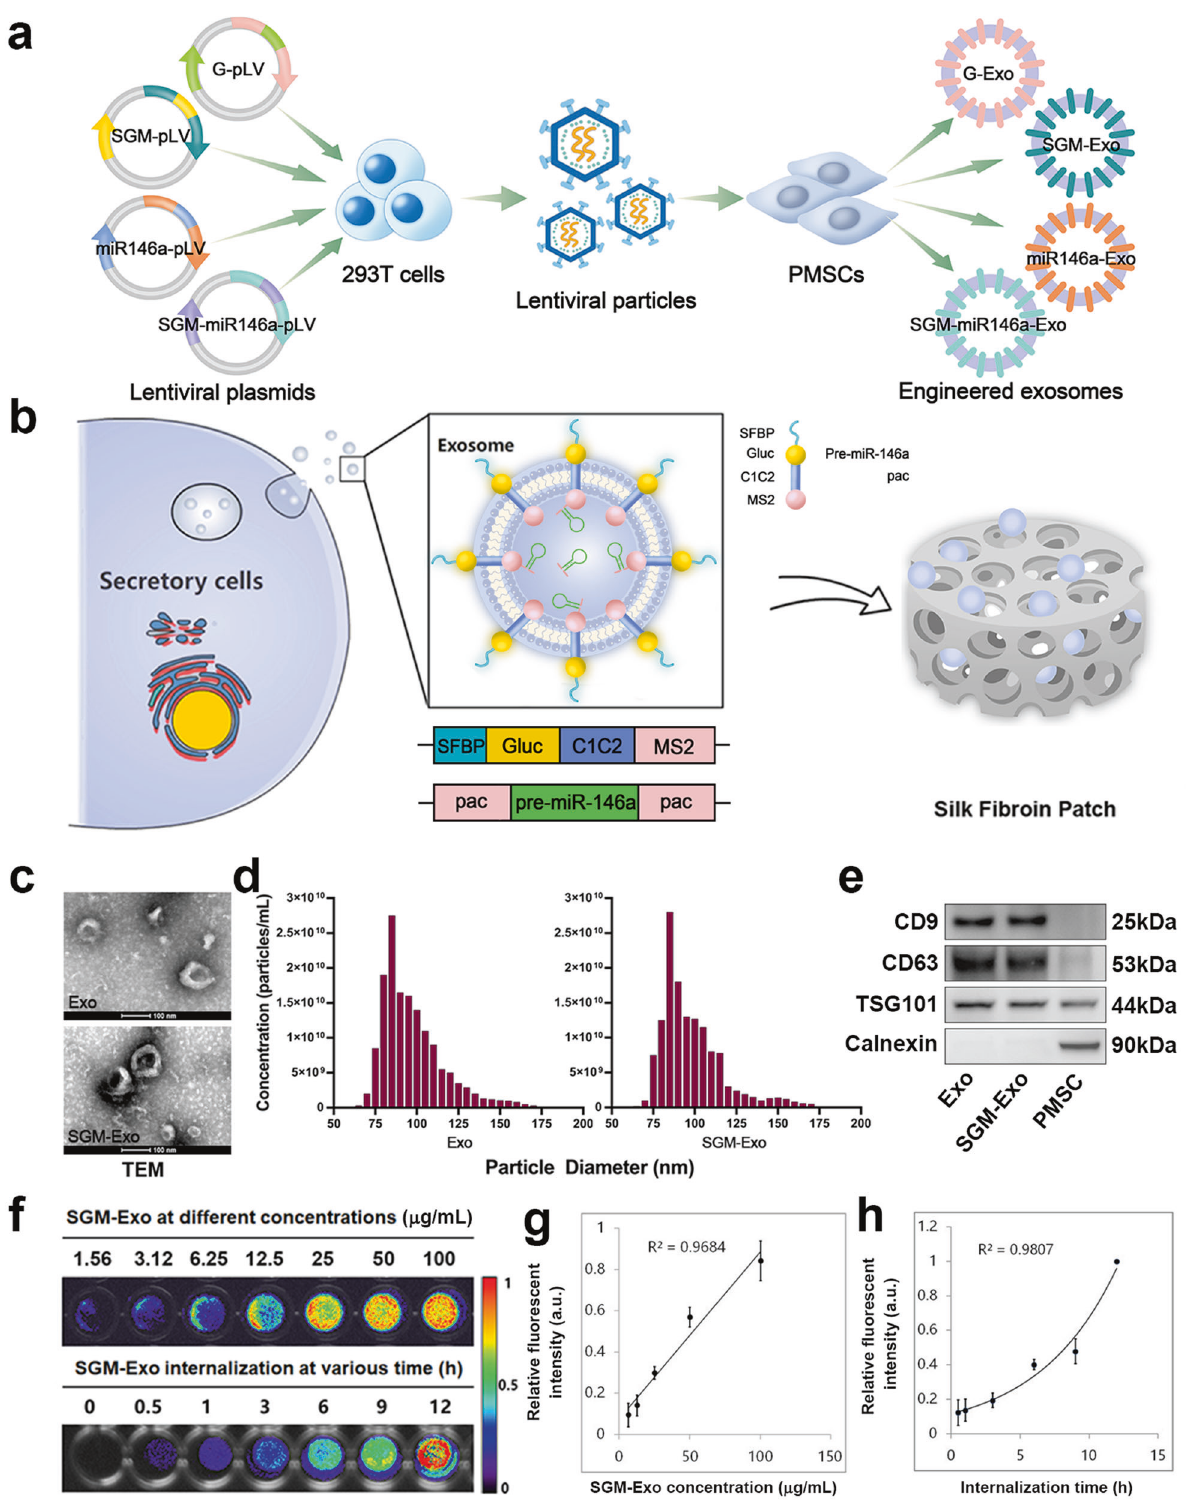
Fig. 1 Generation and characterization of engineered exosomes. a Schematic diagram representing the generation of designed engineered exosomes including G-Exo, SGM-Exo, miR146a-Exo, and SGM-miR146a-Exo. b Schematic of donor cells (left). Schematic of DNA constructs used for the production of SGM-miR146a-Exo (middle). Schematic of silk fi broin patch (right). c Representative transmission electron microscope images for Exos and SGM-Exos (scale bar: 100 nm). d Particle size distributions of Exos and SGM-Exos measured by dynamic light scattering ( n = 4/group). e Western blot analysis of exosome markers. f Representative imaging of bioluminescence signals of SGM-Exos at different concentrations (upper). Representative imaging of bioluminescence signals of SGM-Exos internalized by HaCaT cells (lower). g Graph showing quanti fi cation of SGM-Exos at different concentrations ( n = 4/group, R 2 = 0.9684). h Graph showing quanti fi cation of SGM-Exos internalized by HaCaT cells ( n = 4/group, R 2 = 0.9807) Signal Transduction and Targeted Therapy (2023)